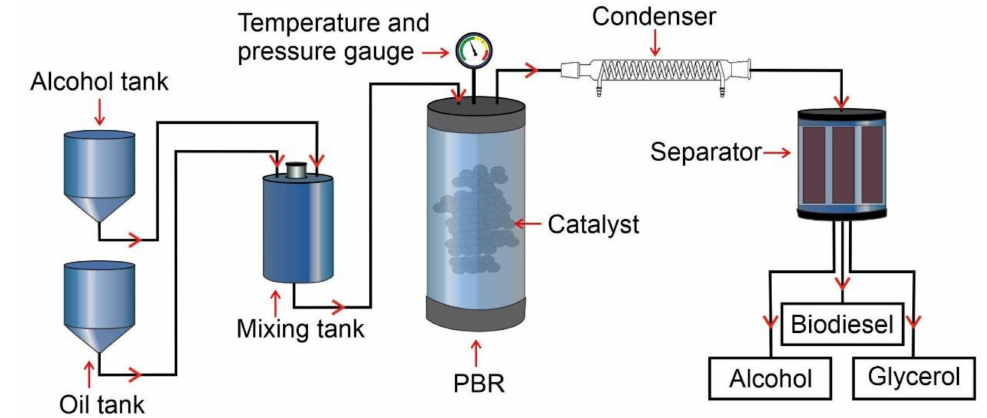
Figure 3. Schematic of packed bed